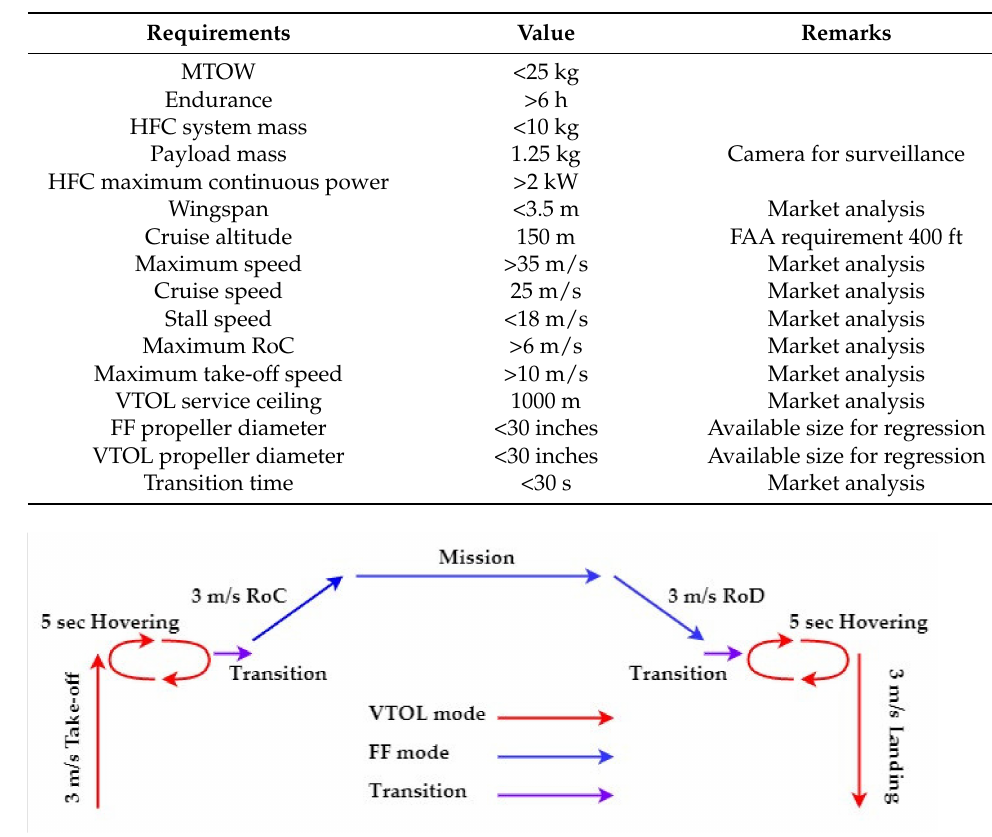
Table 8. The 25 kg hydrogen fuel cell UAV design requirements.